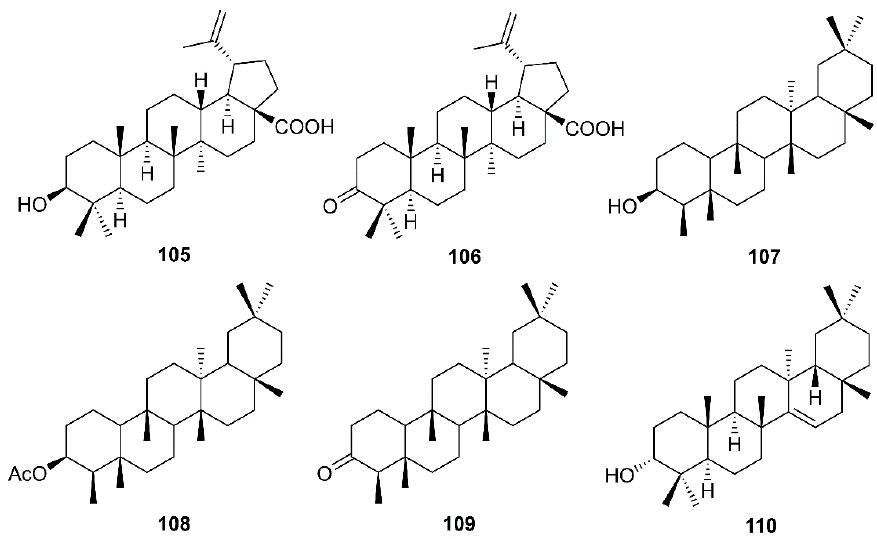
Figure 17. Structures of triterpenoids 105 – 110